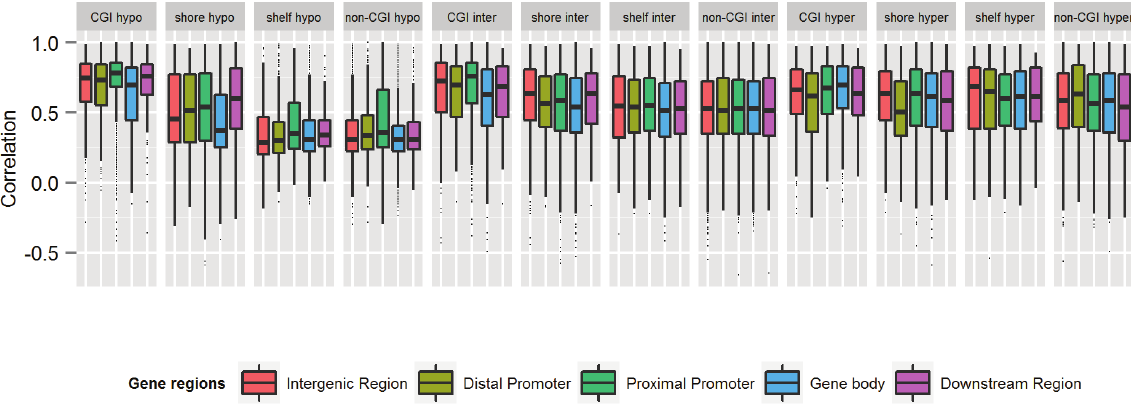
Figure 6. MZ twin correlations for individual CpGs grouped by genomic region and average methylation level. Hypo = Hypomethylated. Inter = intermediate